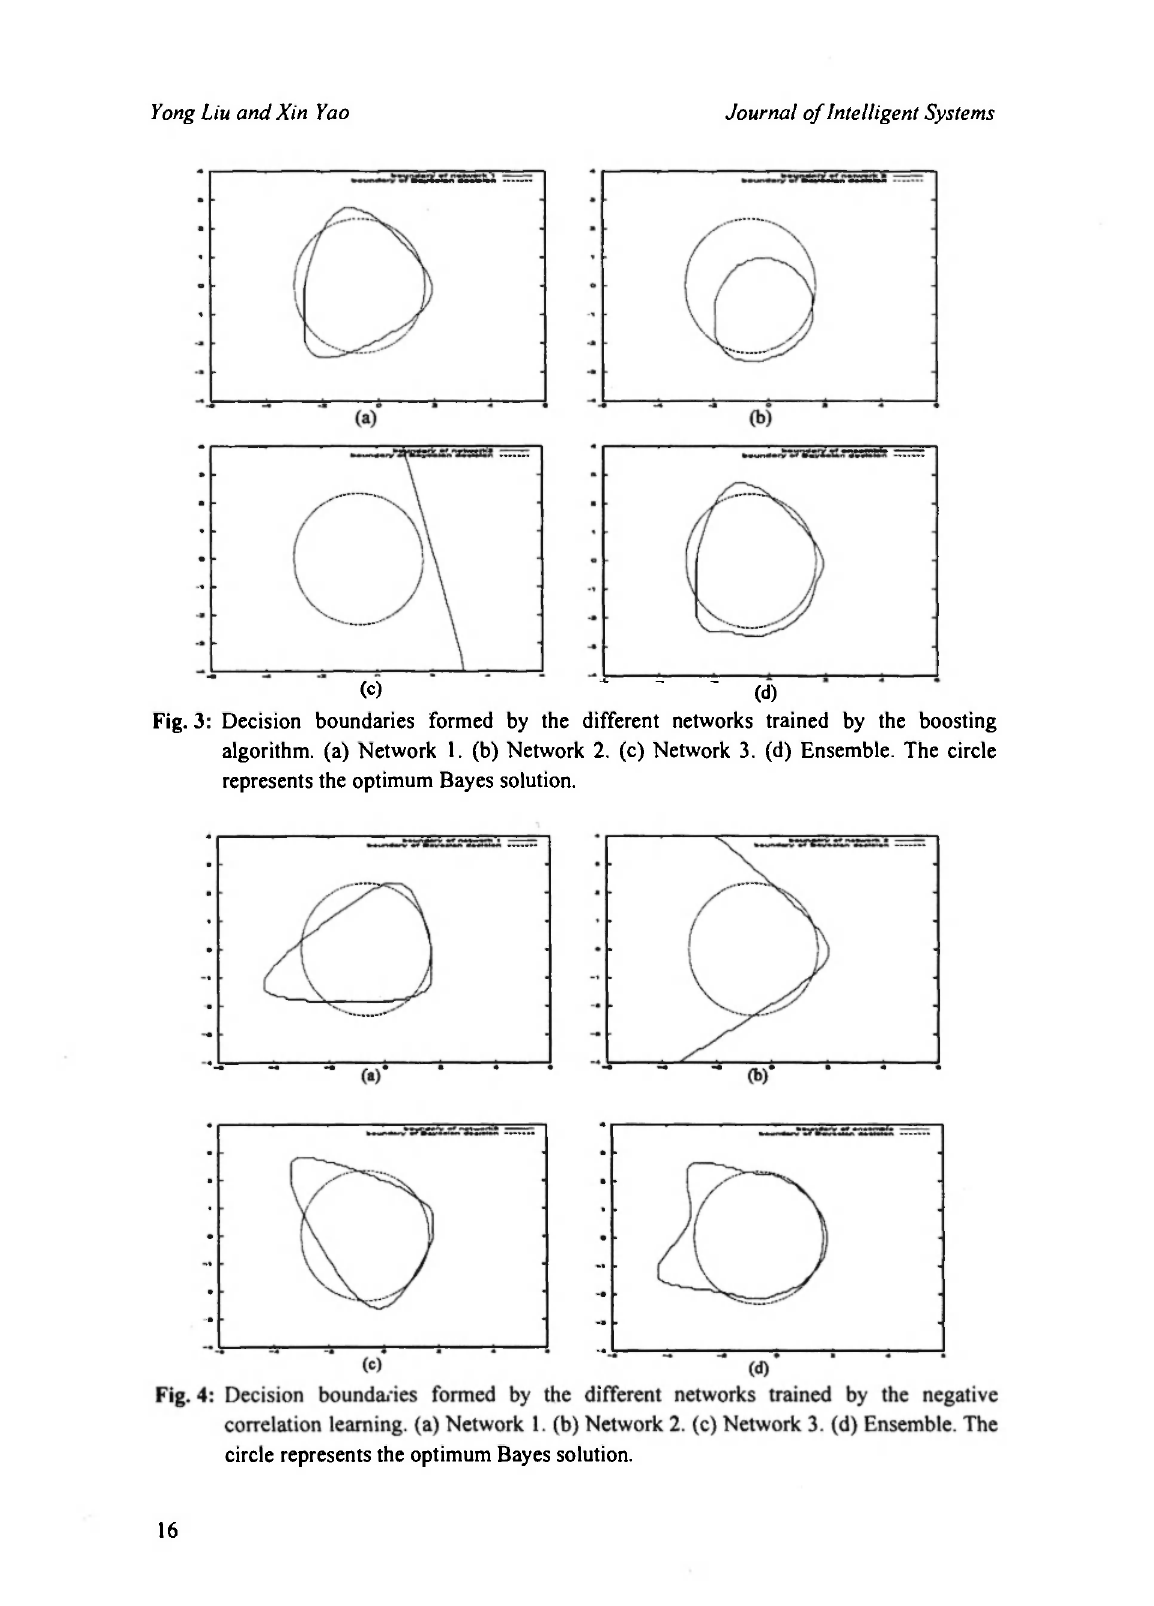
circle represents the optimum Bayes